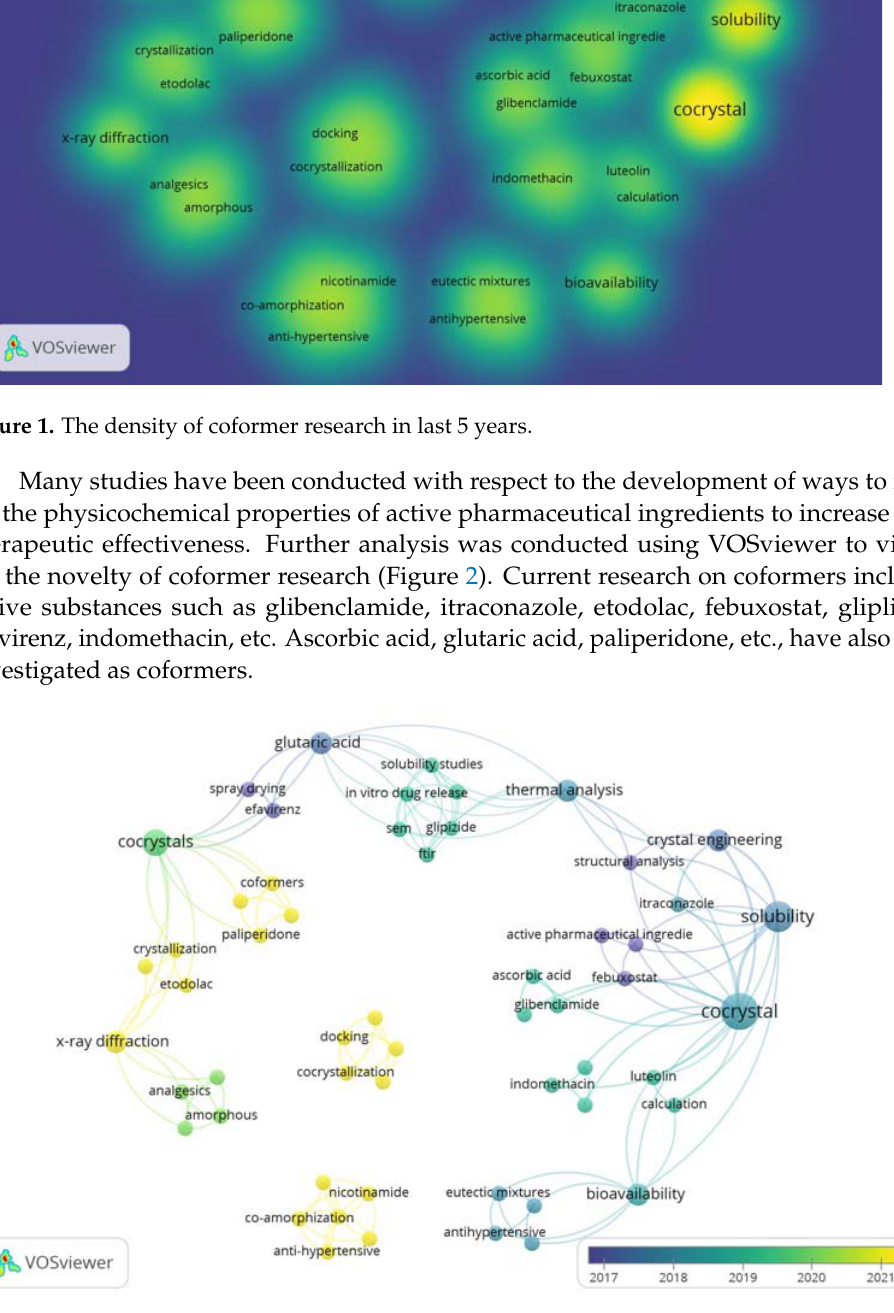
Figure 2. Analysis of coformer research in last 5 years using VOSviewer.